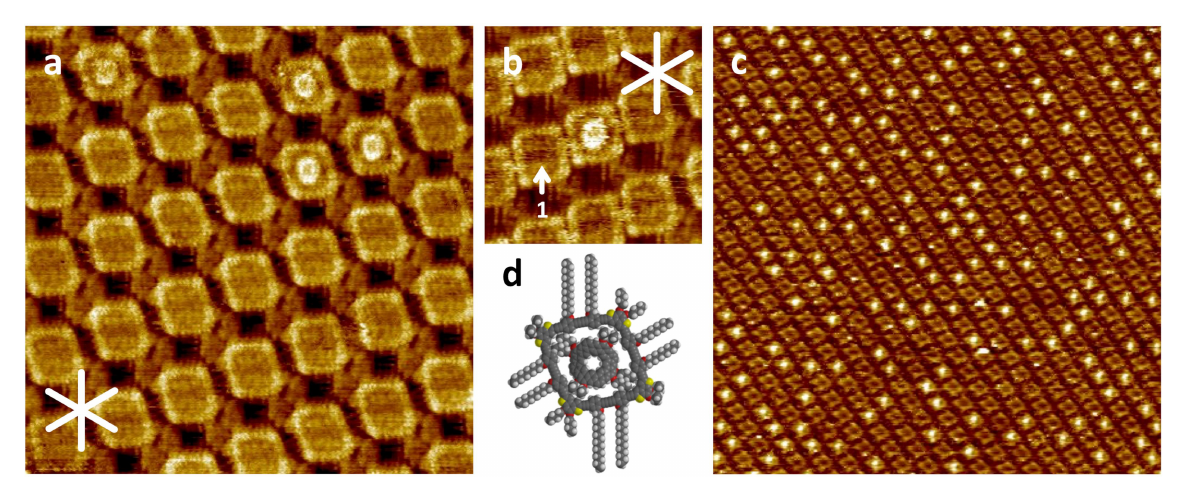
Figure 4: (a–c) Scanning tunneling microscopy images of a nanopattern of 1a with intermolecularly intercalated 3 at the TCB/HOPG interface. Image parameters and sample preparation: (a) 1 µL c ( 1a ) = 5 × 10 –7 M (thermally annealed for 20 s at 80 °C), and 1 µL c ( 2 ) = 1 × 10 − 4 M added at rt; V S = − 0.5 V, I t = 24 pA; 31.2 × 31.2 nm 2 ; (b) 1 µL c ( 1a ) = 5 × 10 − 7 M (thermally annealed for 20 s at 80 °C), and 1 µL c ( 2 ) = 1 × 10 − 4 M added at rt; V S = − 0.8 V, I t = 34 pA; 14.8 × 14.8 nm 2 ; (c) 1 µL c ( 1a ) = 5 × 10 − 7 M (thermally annealed for 20 s at 80 °C), and 1 µL c ( 2 ) = 1 × 10 − 3 M added at rt; V S = − 0.7 V, I t = 44 pA; 158 × 158 nm 2 and (d) proposed intercalation model. White lines indicate the HOPG main axis